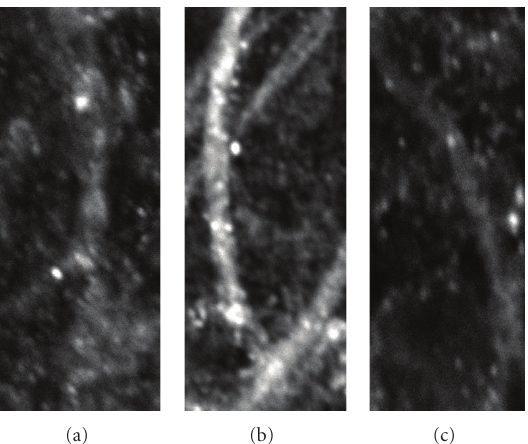
Figure 3: Phosphorylation of NR1 subunit of the NMDA receptor (pNR1) was immunohistochemically detected using an antibody. pNR1 immunoreactivity increased in response to ghrelin (b) when compared with control (a). This e ff ect was blocked by the antagonist of the ghrelin receptor, L-Dys3-GHSR (c). Calibcation: 5 μ m. Adopted and modified from Cuellar and Isokawa